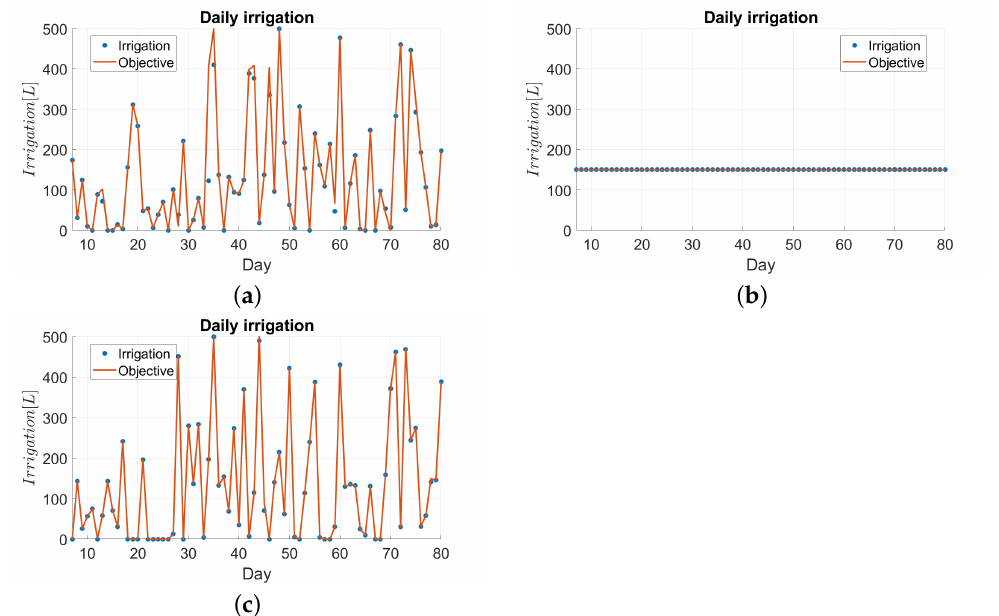
Figure 13. Comparison between the daily irrigation V r and the corresponding objective ¯ V for different irrigation scenarios. The actual irrigation is shown by the blue points, and the corresponding objective is represented by the red lines. ( a ) Daily irrigation V r and the corresponding objective ¯ V for the EWMS irrigation case; ( b ) daily irrigation V r and the corresponding objective ¯ V for the manual irrigation case; ( c ) daily irrigation V r and the corresponding objective ¯ V for the combined irrigation